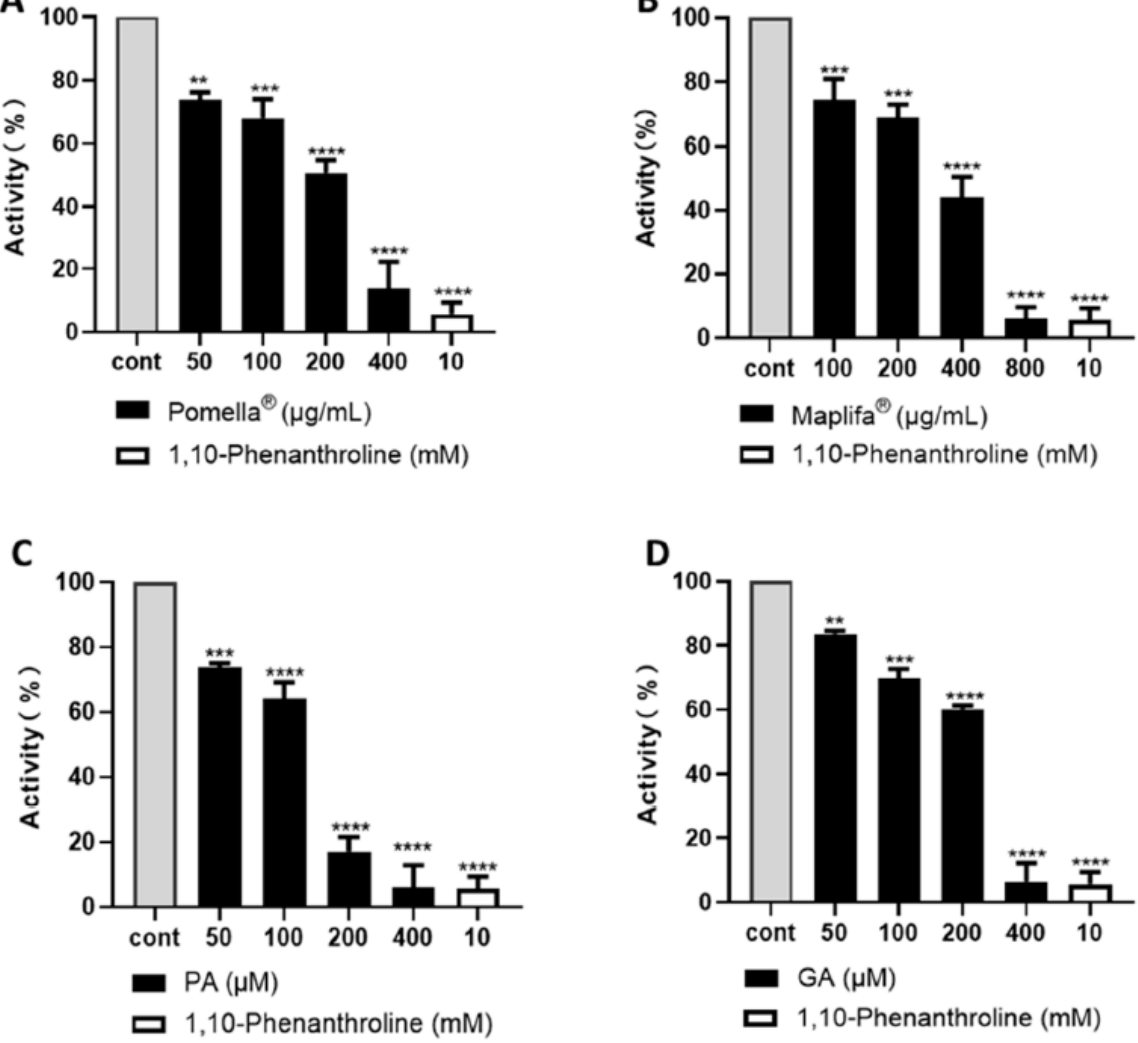
Figure 1. Inhibition of collagenase enzyme activity by ( A ) Pomella ® and ( B ) Maplifa ® (both at 100, 200, 400, and 800 µg/mL), and ( C ) PA and ( D ) GA (both at 50, 100, 200, and 400 µM). The inhibitory effects were determined by a colorimetric assay. Data are expressed as means ± standard deviation (S.D.) from three replicated experiments. Statistically significant difference was considered ** p < 0.01, *** p < 0.001 and **** p < 0.0001 when compared to the control group. Furthermore, through the CI values of the inhibitory effects from the combination of different concentrations of both Pomella ® and Maplifa ® , as well as PA and GA, we assessed the synergistic potential and observed that the combinations of Pomella ® and Maplifa ® exerted synergistic inhibitory effects on collagenase activity. The inhibitory effects of the combinations were separately obtained and compared to the activity of their individual samples (Figure